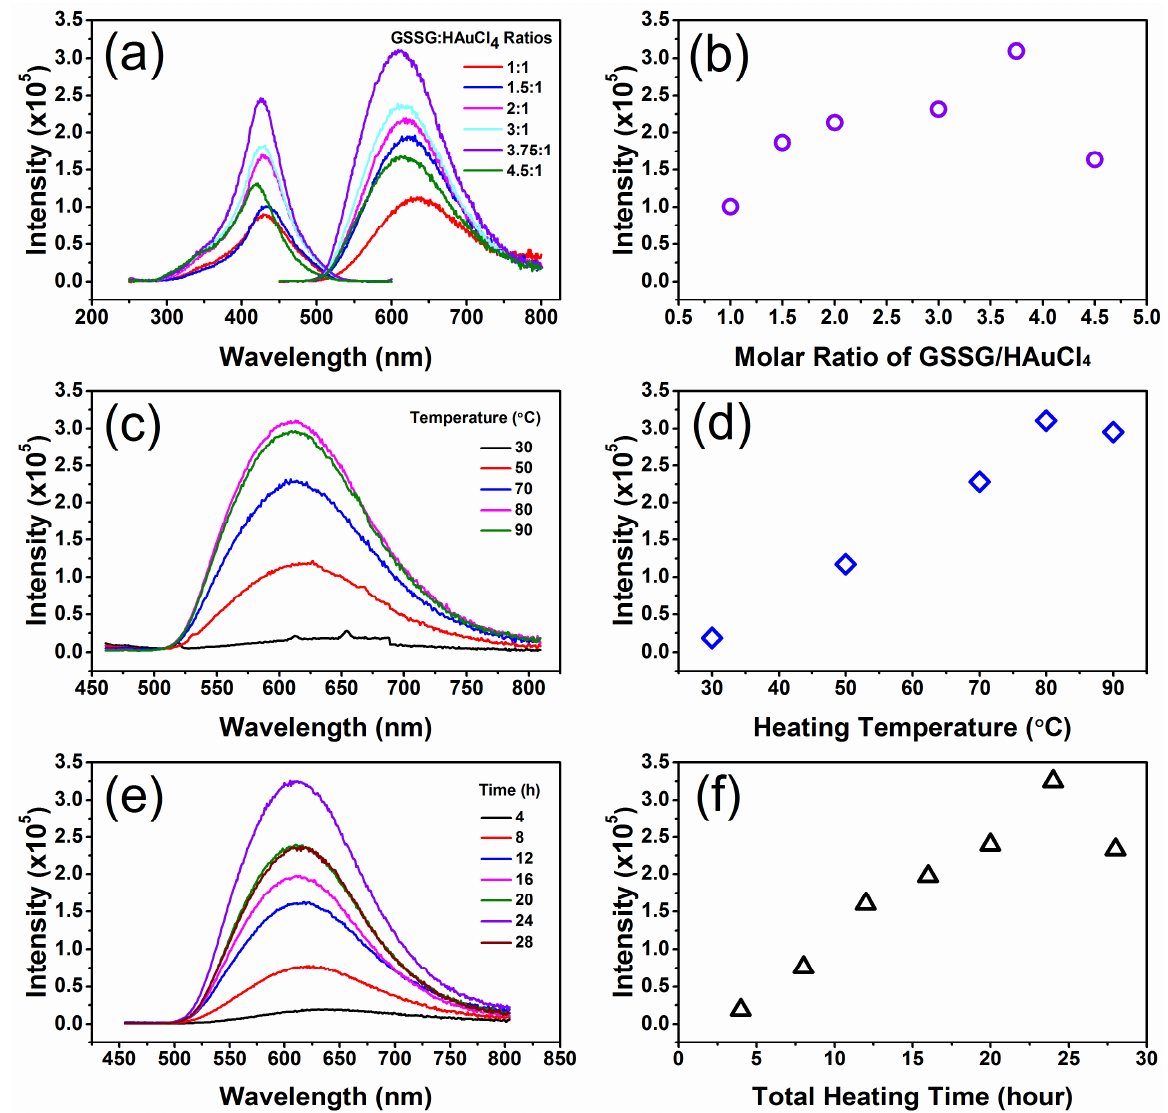
Figure 1. Optimization of the synthesis parameters. ( a ) Influence of the initial GSSG/HAuCl 4 molar ratio on the excitation (left) and emission (right) of the GSSG–AuNCs; ( b ) variation of the emission maximum as a function of the GSSG/HAuCl4 molar ratio; ( c ) influence of the heating temperature on the emission spectra of the nanoclusters; ( d ) plot of emission intensities under different reaction temperatures; ( e ) effect of total heating time; and ( f ) dependence of emission intensity on the total reaction time. In the above experiments, the concentration of HAuCl 4 was kept at 2 mM.